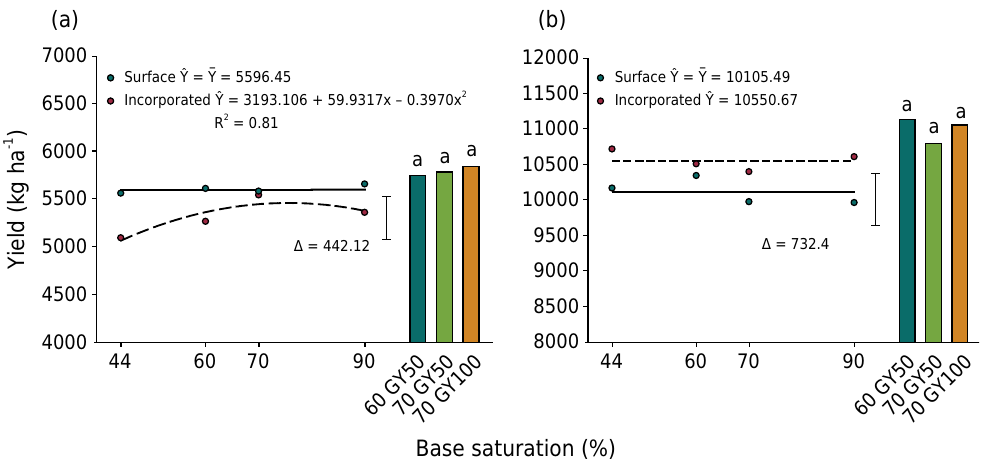
Figure 7. Yield of wheat (a) and corn (b) after reapplication of lime and phosphogypsum. Different letters above the bars indicate a significant difference between the treatments with phosphogypsum based on Tukey’s test (p<0.05). The vertical bar indicates the DMS between each factorial vs additional treatment determined by a Dunnett test (p<0.05). An F test revealed a significant difference between the modes of lime application in wheat (p<0.00) and corn yield